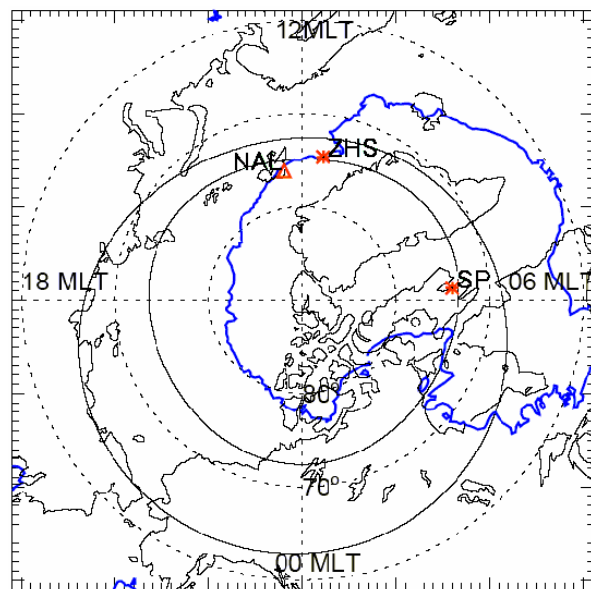
Fig.2 The map of the Arctic and Antarctic in altitude adjusted corrected Fig. 2. The map of the Arctic and Antarctic in altitude-adjusted, geomagnetic (AACGM) coordinates, looking down on the geomagnetic north pole at 10:00 UT. The boundaries of the auroral oval (Q = 3) are shown as solid lines in the corrected geomagnetic (AACGM) coordinates, looking down on the Figure. geomagnetic north pole at 10:00 UT. The boundaries of the auroral oval (Q=3) are shown as solid lines in the figure.